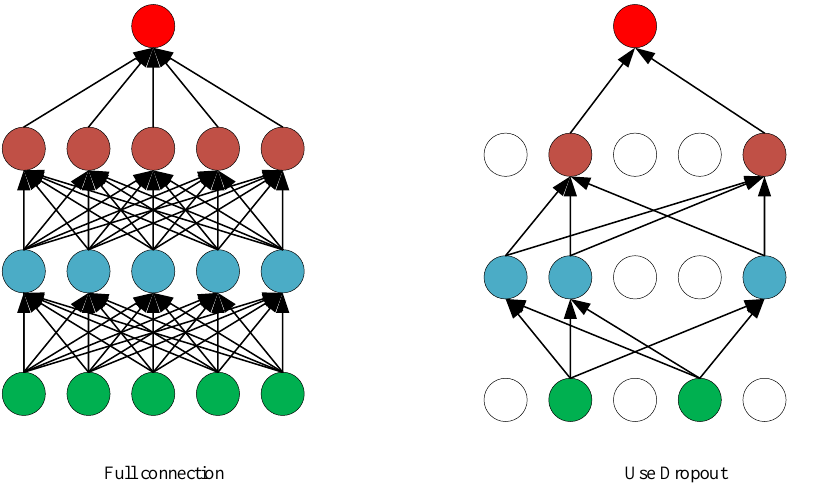
Figure 6. The principle of Dropout.